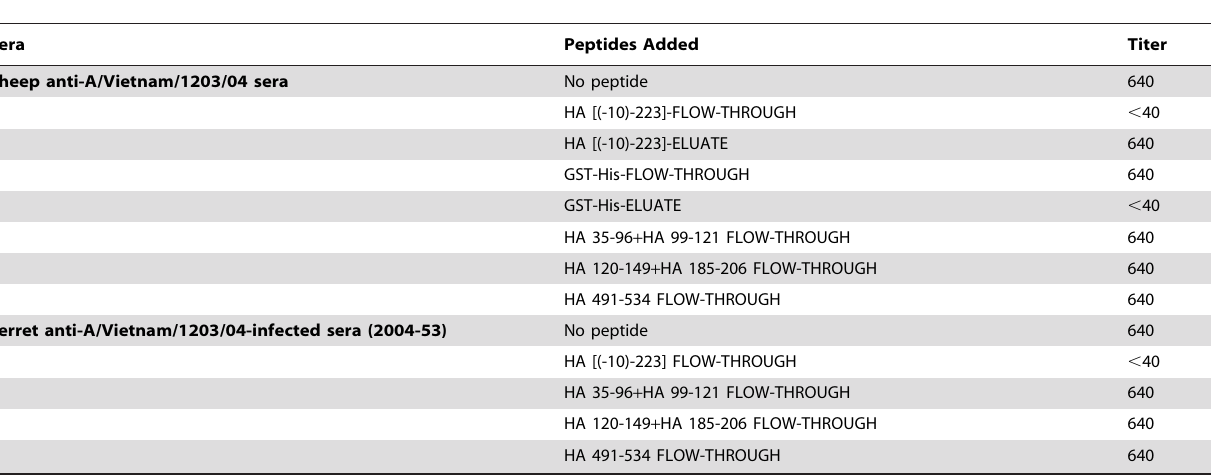
HA [(-10)-223] can adsorb most of the neutralizing activity in polyclonal sera. Sera from sheep hyperimmunized with bromelain-treated rgA/Vietnam/1203/2004 (FDA), or from ferrets infected with wild-type A/Vietnam/1203/2004 virus (CDC) were adsorbed on different H5 HA peptides and subjected to a microneutralization assay performed with rgA/Vietnam/1203/2004 virus. End-point neutralization titers of various pre- or postadsorbed sera are shown. doi:10.1371/journal.pmed.1000049.t001 PLoS Medicine |